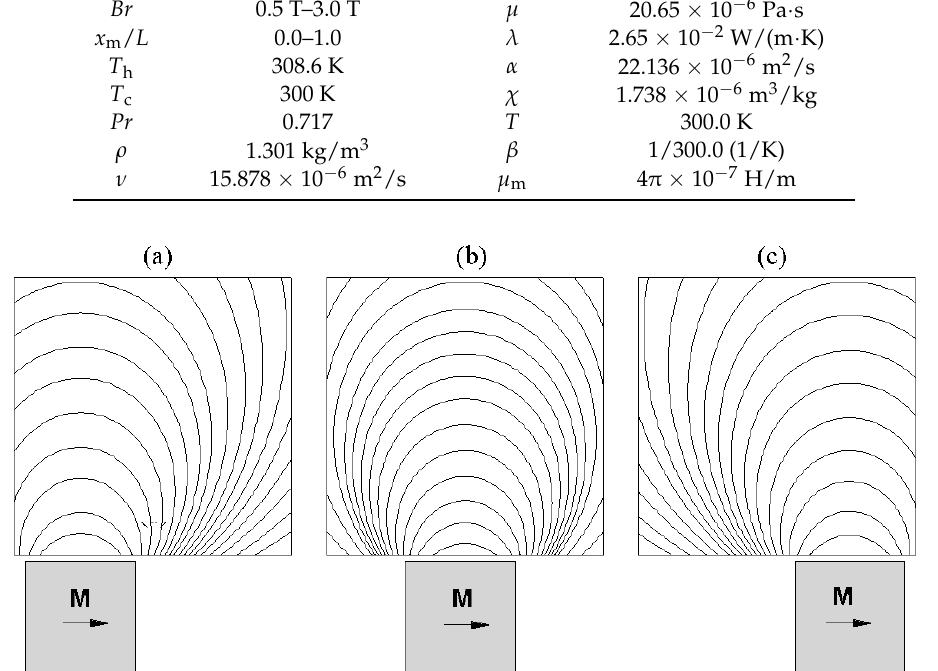
Figure 1. Schematic view of the physical model. Table 1. Parameters and physical properties of oxygen [15] (300 K, 1 atm).